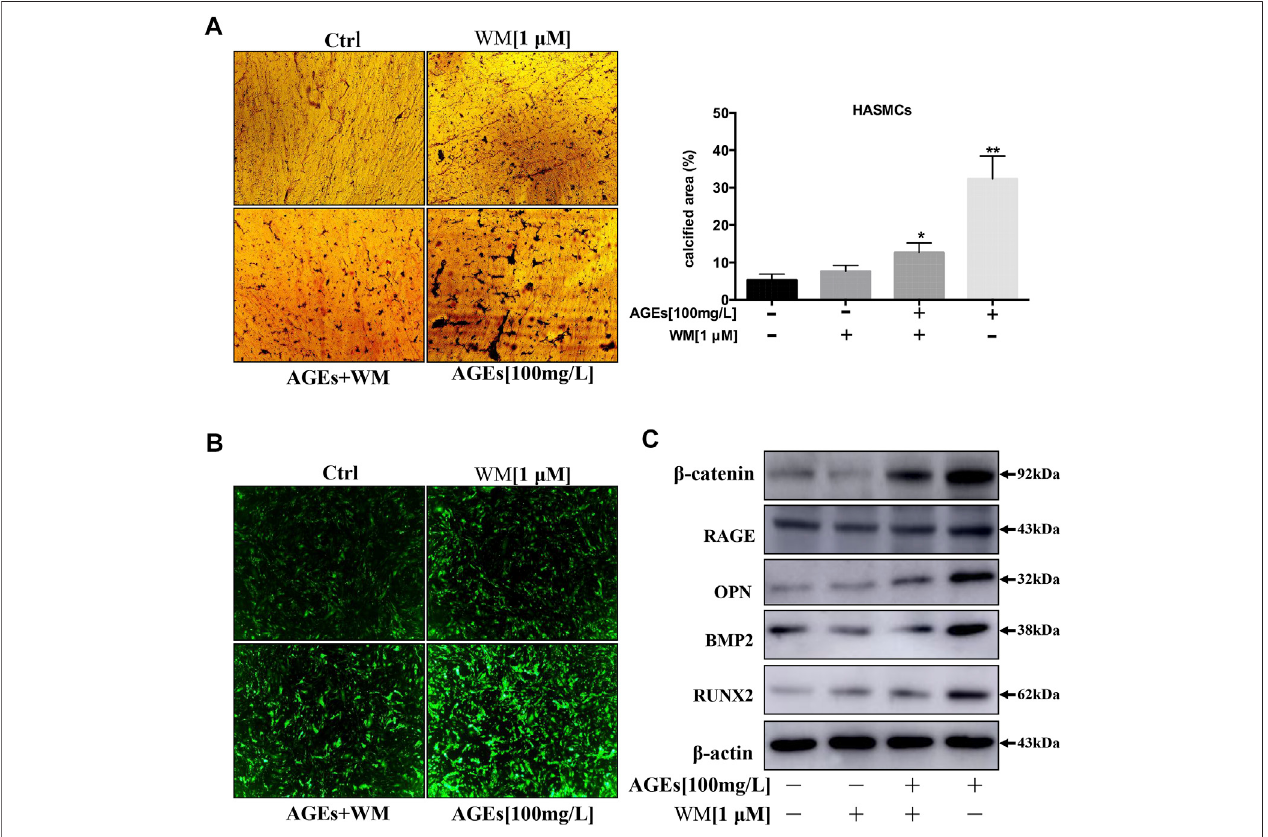
FIGURE6| WMinhibitsthecalci fi cationofHASMCs byinhibiting autophagy. (A) Depositionofcalcium wasquanti fi ed byvonKossastainingin14 days-AGEsand WM-treated HASMCs. The black spots in the image represent calci fi ed areas; scale bar (cid:2) 100 µm ( × 10). Each point represents the mean ± SD ( n (cid:2) 3/group). (B) Intracellular Ca 2+ was quanti fi ed with FLIPR Calcium 6 dye (green) in AGEs and WM-treated HASMCs; scale bar (cid:2) 100 µm ( × 10). (C) Western blot analysis of calci fi cation-related proteins ( β -catenin, RAGE, OPN, BMP2, and Runx2) in HASMCs.